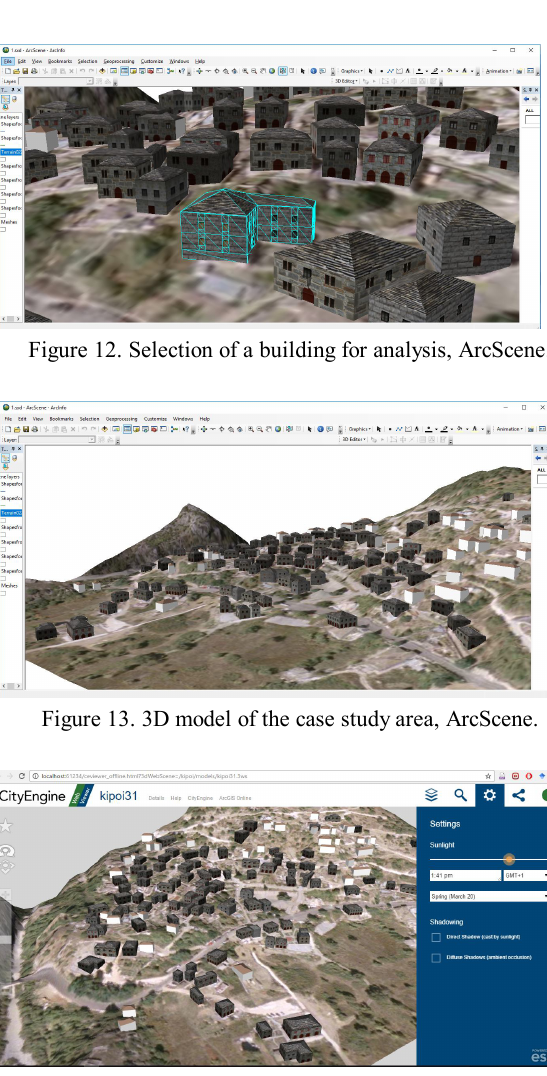
Figure 14. 3D model of the study area, CityEngine Webscene Viewer.